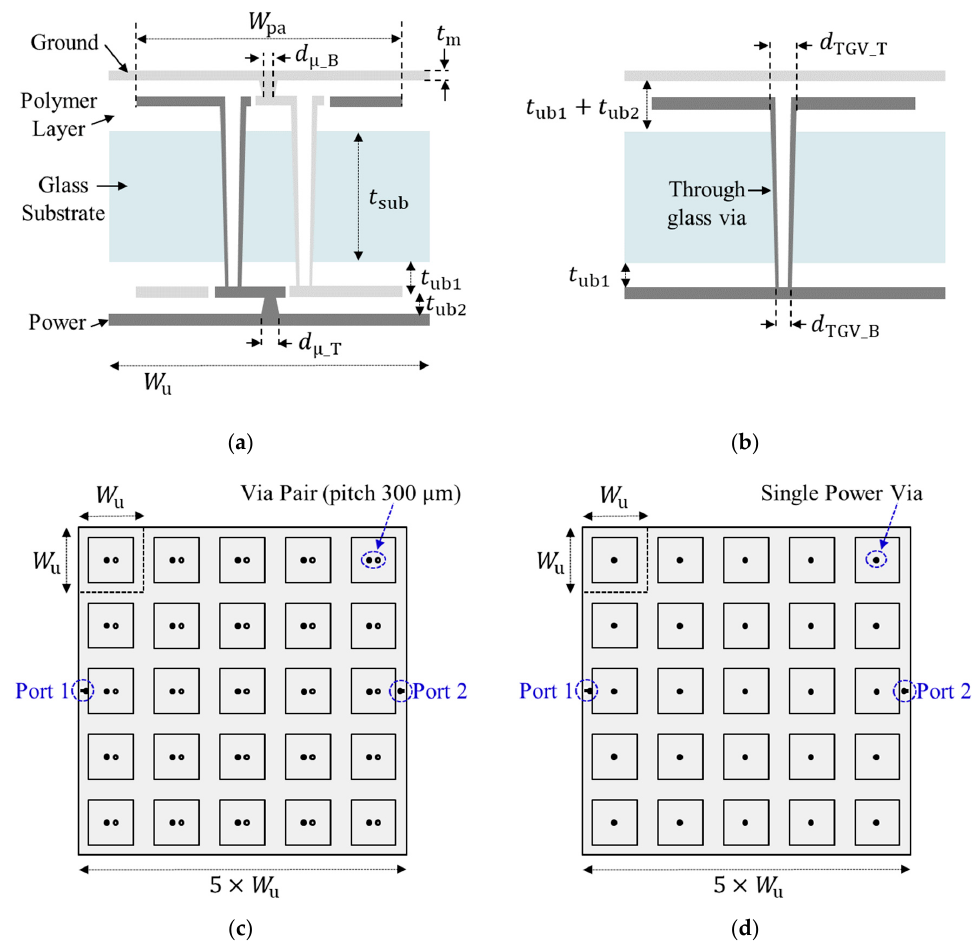
Figure 6. Designed noise suppression structures in the glass interposer test vehicles. ( a ) Type A: double-patch structure; ( b ) Type B: single-patch structure. Top view of the fabricated test vehicles composed with ( c ) Type A and ( d ) Type B. Each test vehicle has 25 unit structures. Table 2. Physical dimensions and material properties of the glass interposer test